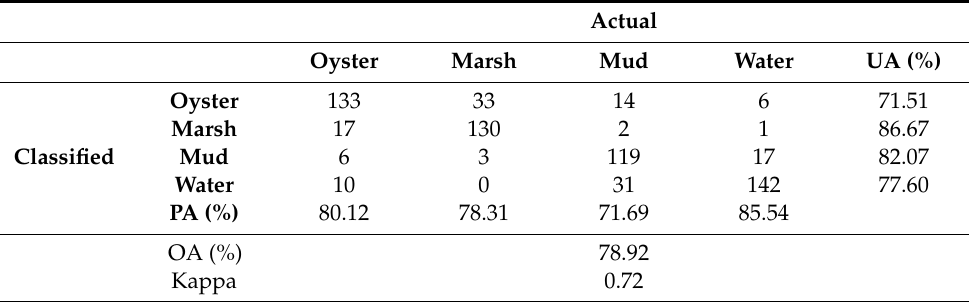
Table 2. Confusion matrix of the actual and classified habitat covers with the accuracy of results. UA = user’s accuracy PA = producer’s accuracy, and OA = overall